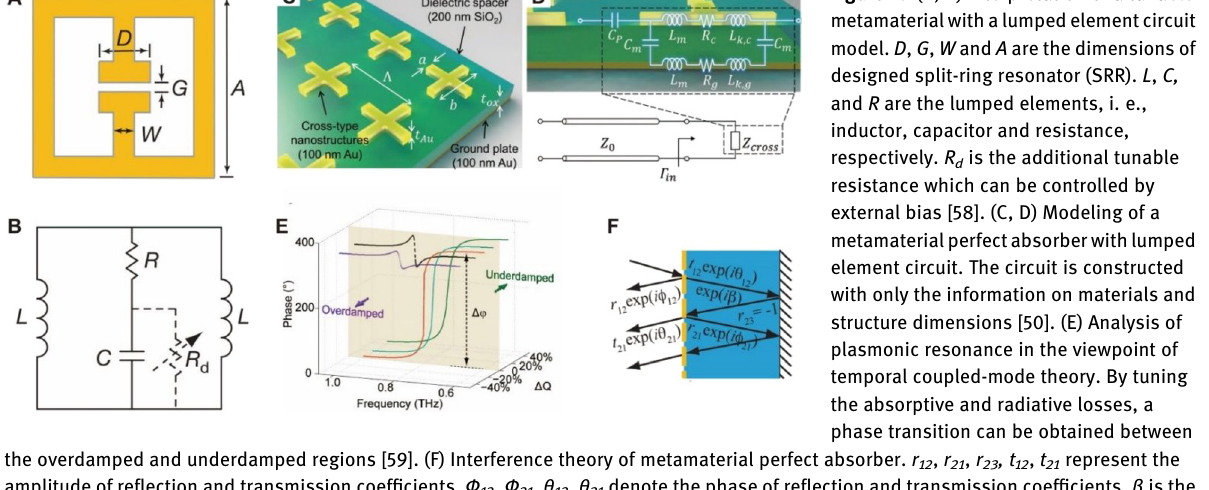
Figure 2B. In their design, an additional switchable resistor can be introduced into the circuit by controlling the depletion layer of the substrate via external bias. The existence of this additional resistor certainly affects the effective impedance of the equivalent circuit, leading to a large modulation of THz transmission by 50%. This lumped equivalent circuit model is widely applied in the analysis of MEMS actuated metamaterials, especially the pre-stressed cantilever-based metamaterials. The unit cell of this type of metamaterial is a bimorph cantilever, where the free end bends up and the other end is anchored at the substrate. As in Eq. (1), the resonance frequency is decided by the effective inductance and capacitance.